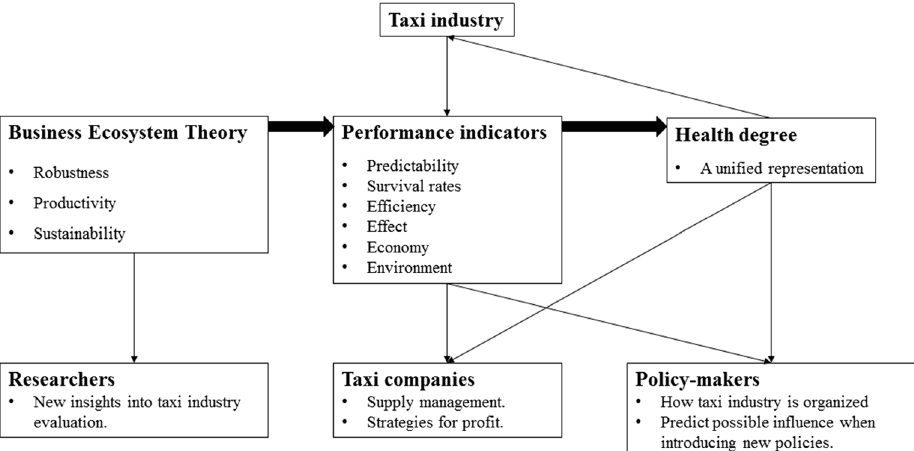
Fig. 2 Structure of the proposed taxi industry evaluation